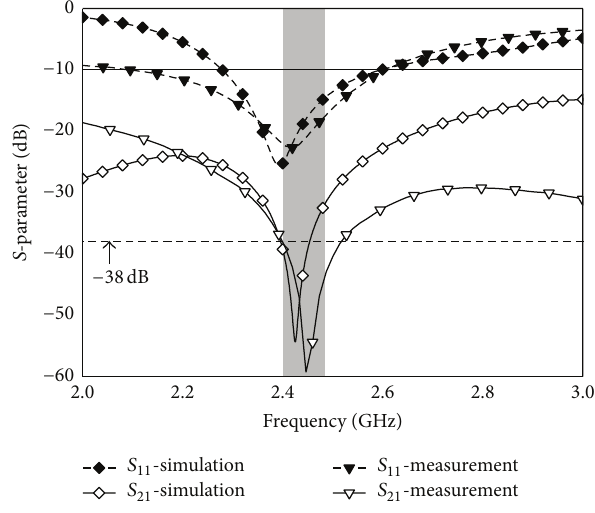
Figure 8: Simulated and measured 𝑆 -parameter results for the proposed antenna on the human muscle-equivalent flat phantom.